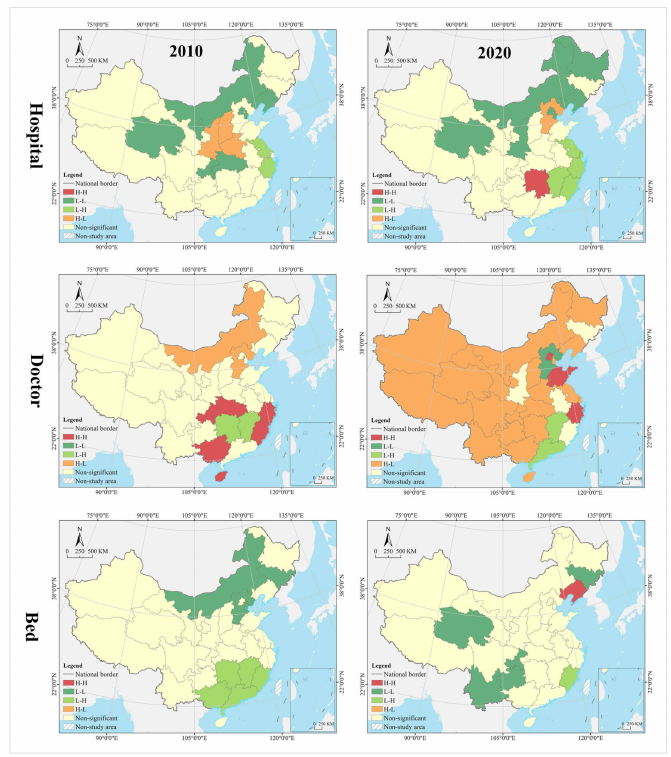
Figure 9. Spatial autocorrelation analysis of mismatch type for